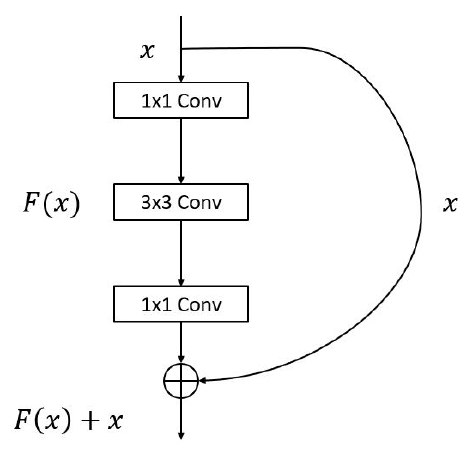
Figure 6. Operation declaration of the residual connection in a deep neural network.